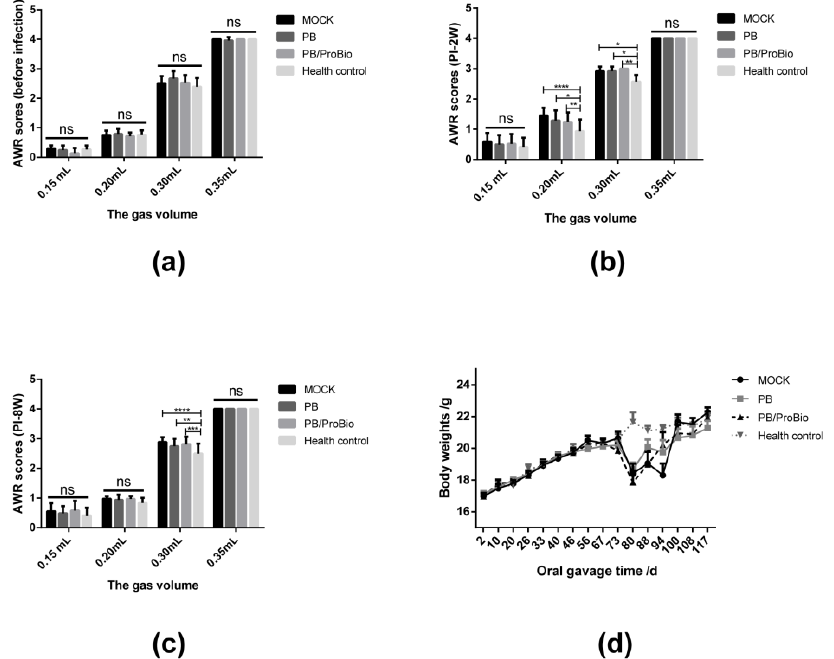
Figure 4. The change of body weights and Abdominal Withdrawal Reflex (AWR) scores in the 4 groups. AWR scores at different levels of distension in ( a ) one-week pre-infection, ( b ) 2 weeks post-infection, and ( c ) 8 weeks post-infection. n = 15 in each group. ( d ) The change of body weights. * p < 0.05, ** p < 0.01, *** p < 0.001, **** p < 0.0001.